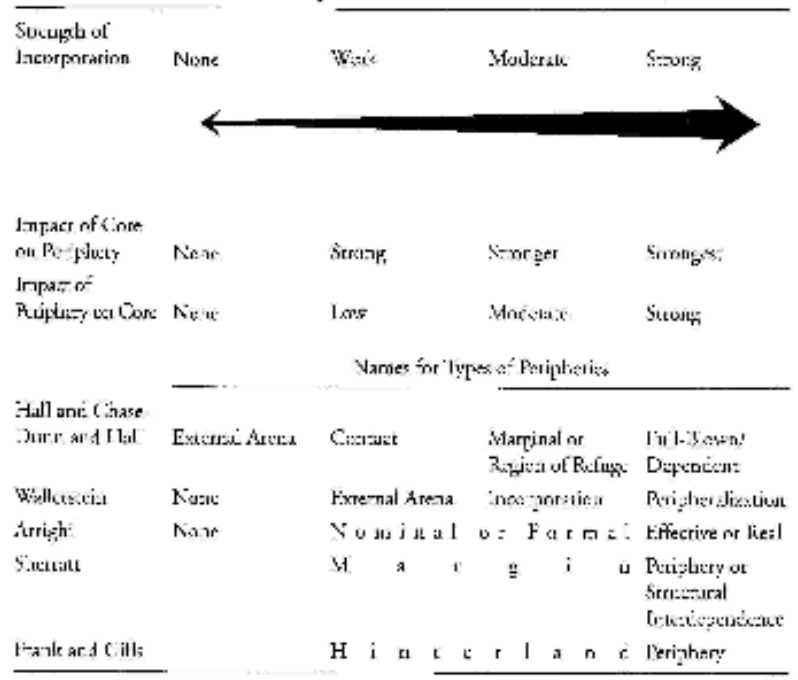
(from Chase-Dunn and Hall